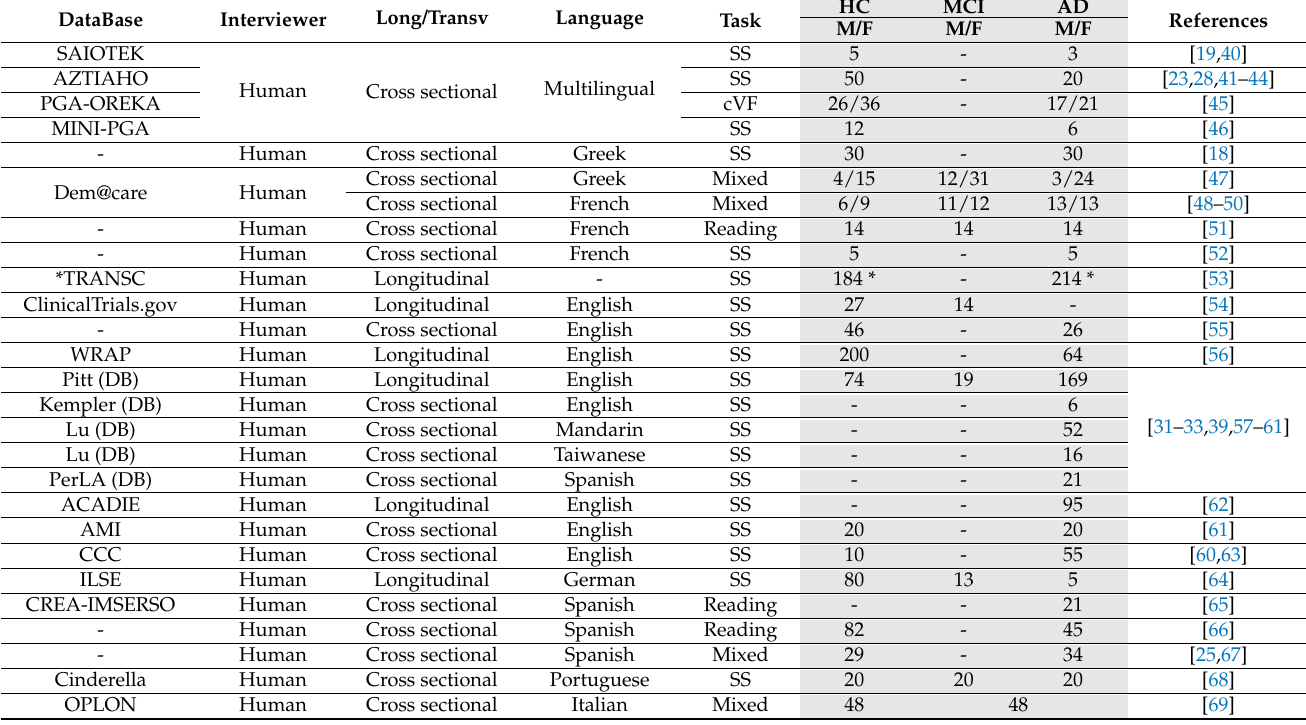
Table 1. Databases of recordings used for linguistic analysis of localized Alzheimer’s disease (AD) and types of study according to the distribution in time of taking measurements and the type of interviewer